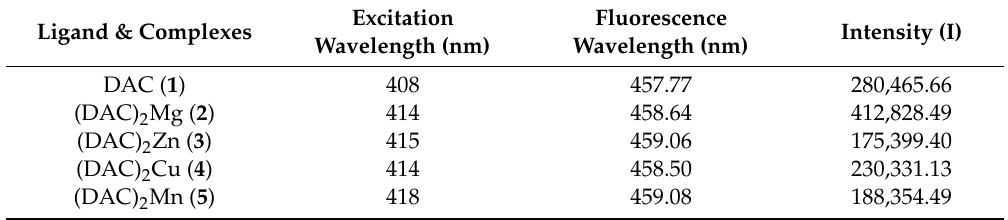
Table 2. Fluorescence of diacetylcurcumin (DAC) and metal complexes in dimethylsulfoxide (DMSO).